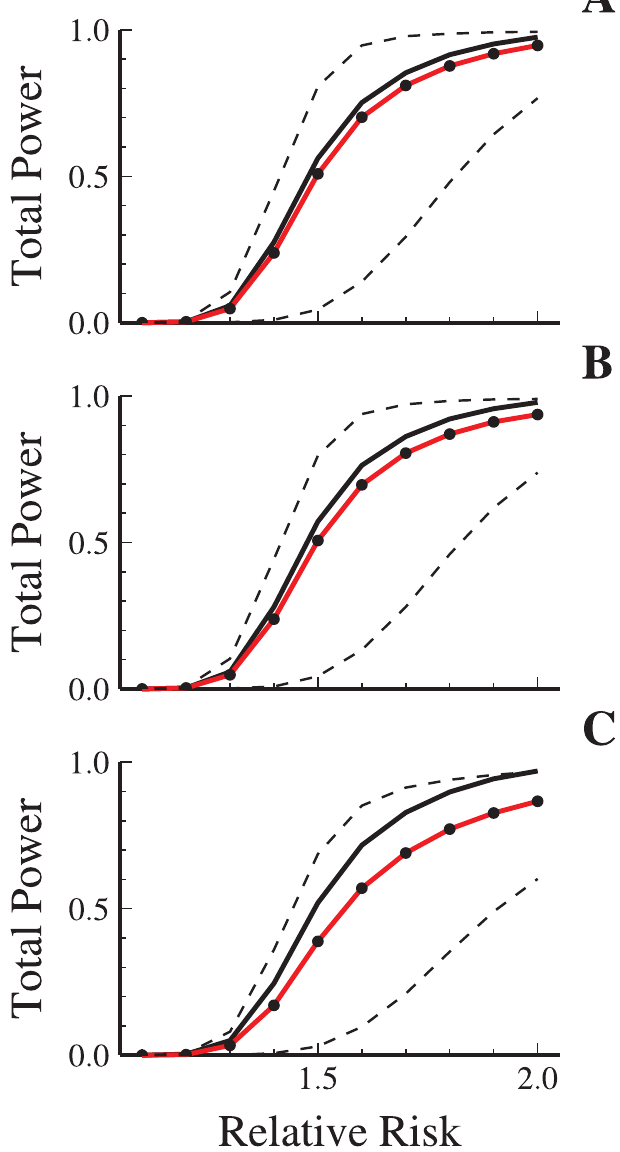
Figure 2. Total Power to Detect a Single Common Risk Allele in the HapMap Data Using HumanHap550 for CEU (A) and CHB þ JPT (B) and HumanHap650Y for YRI (C) in a Study Size of 1,000 cases and 1,000 Controls under a Multiplicative Disease Model Power is calculated for a 5% false discovery rate after a Bonferroni correction for multiple testing (red line). The solid black line represents the power to detect a risk allele if all the common HapMap SNPs in each respective population are genotyped using the same significance cutoff. Also shown are the powers for different frequency ranges as dashed lines, where the lower line indicates the power for risk allele frequencies from 5%–10% and the upper line indicates the power for risk allele frequencies from